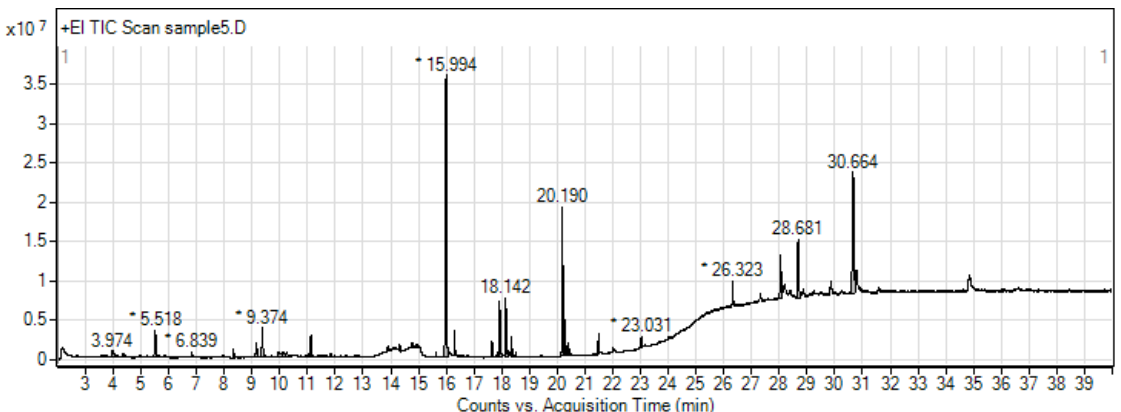
Figure 7. GC-MS/MS chromatogram of Momordica charantia L. (MC). * Peaks of proposed phytochemical compounds in MC as suggested by GC-MS/MS.